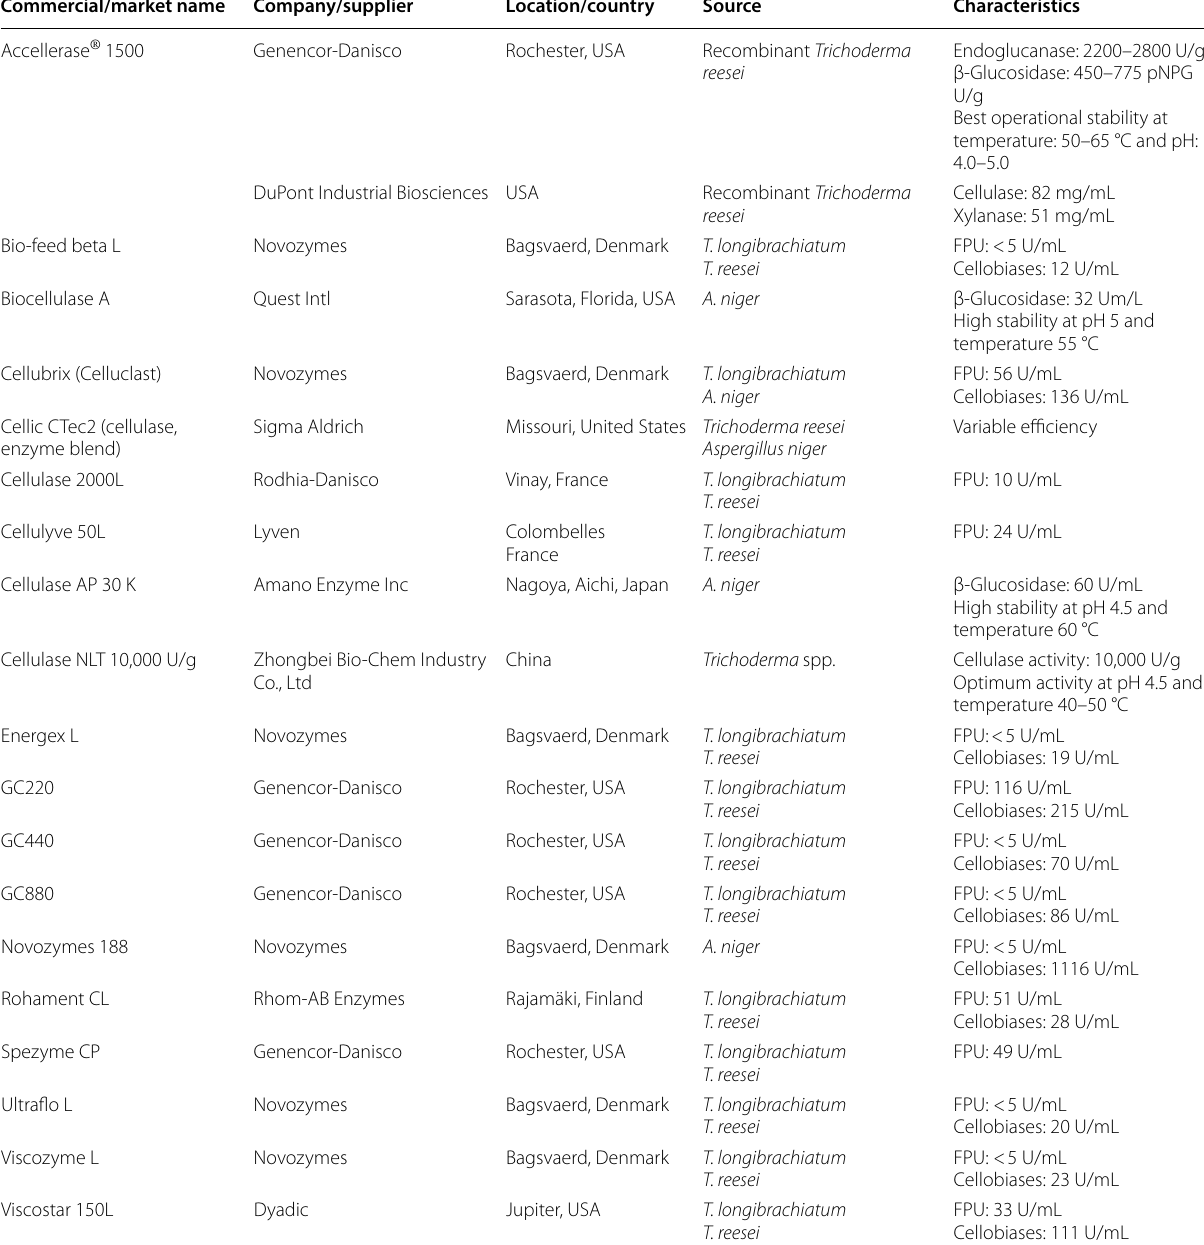
Table 5 List of commercial cellulase producer and suppliers with its source and characteristics. Source: Verardi et al. (2012), and company’s